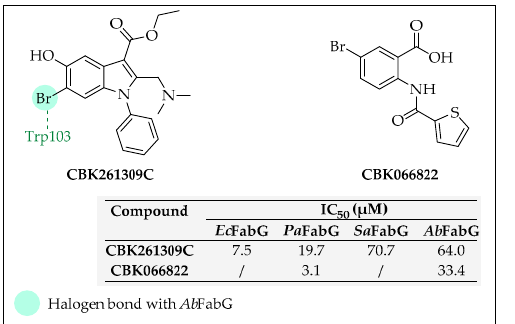
Figure 19. Structures, representation of main interaction with Ab FabG and in vitro activities of CBK261309C and CBK066822